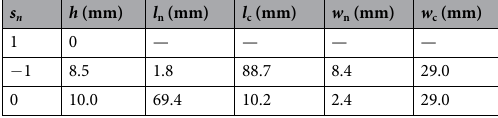
Table 3. Geometrical parameters of the